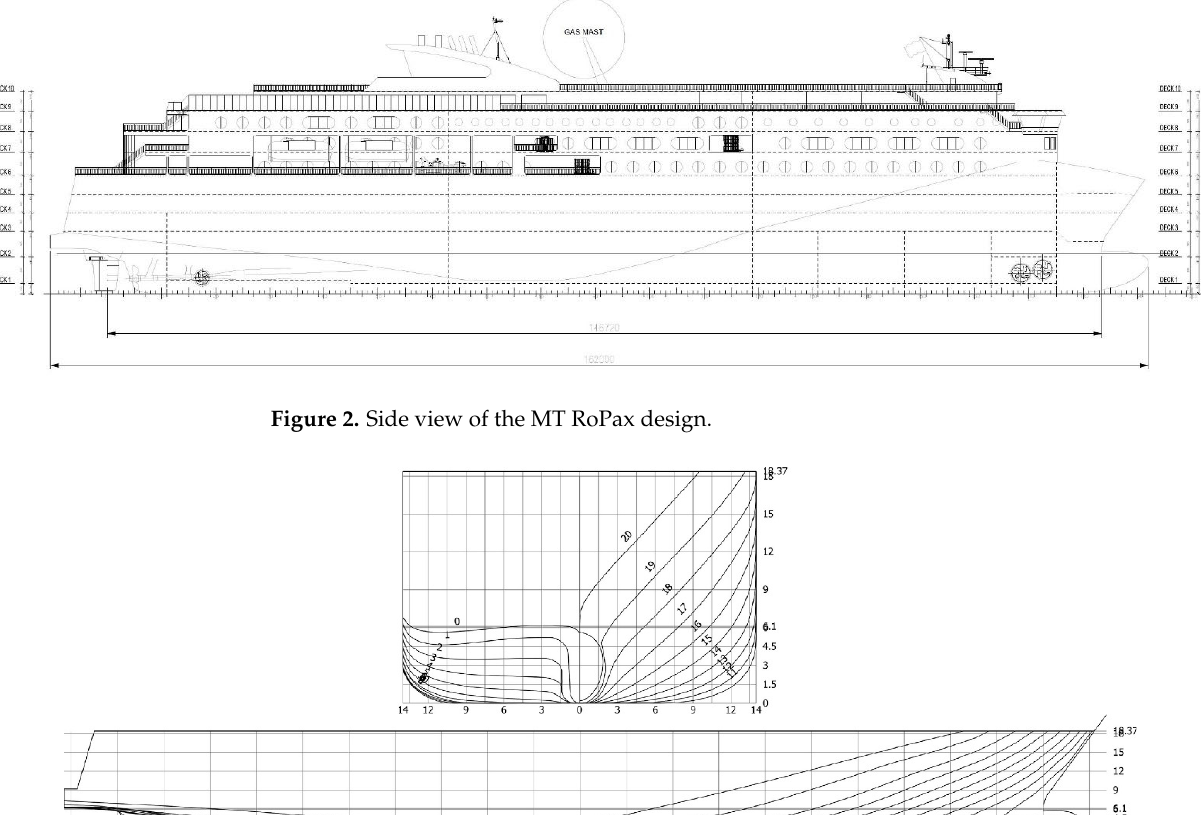
Figure 2. Side view of the MT RoPax design.